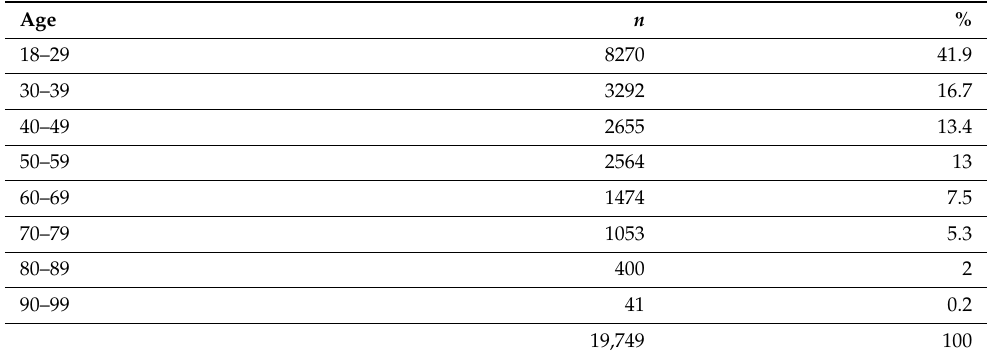
Table 1. Age distribution of adult patients with acute appendicitis, 2010–2017 ( n =